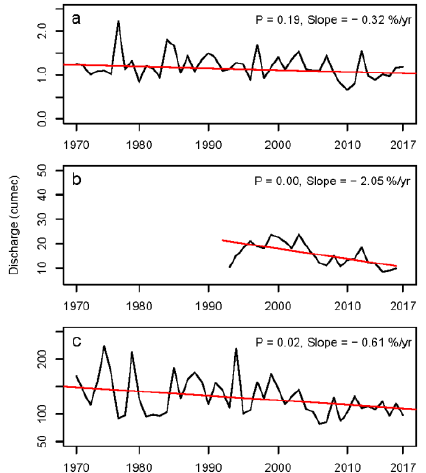
Figure 5. Long-term trend in annual average discharge of ( a ) headwater, ( b ) upper and ( c ) entire Bagmati catchments.